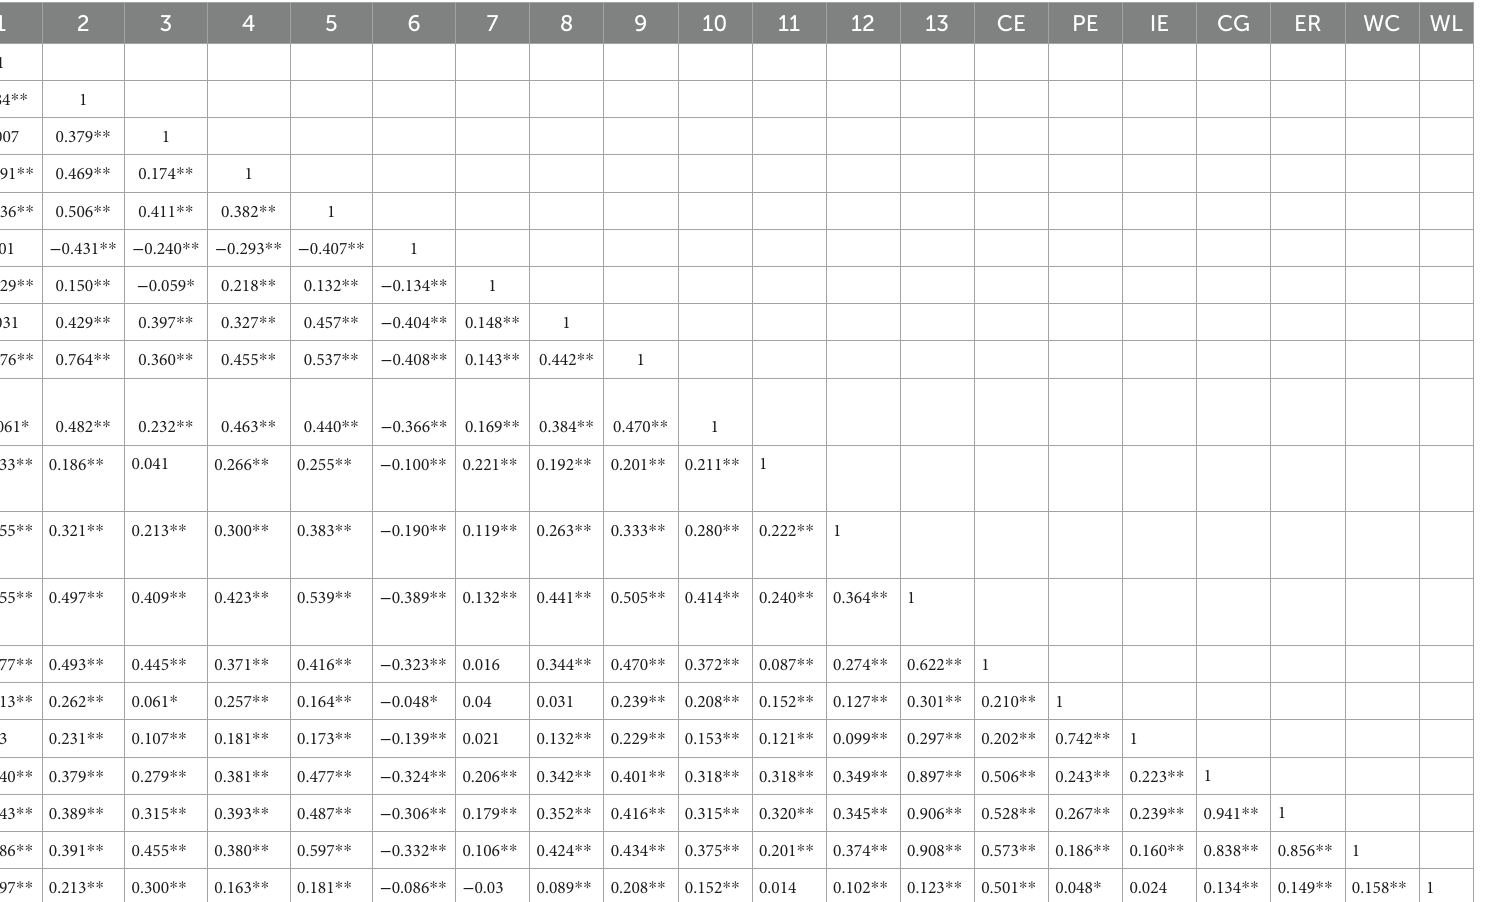
TABLE 6 Correlation analysis of variables.